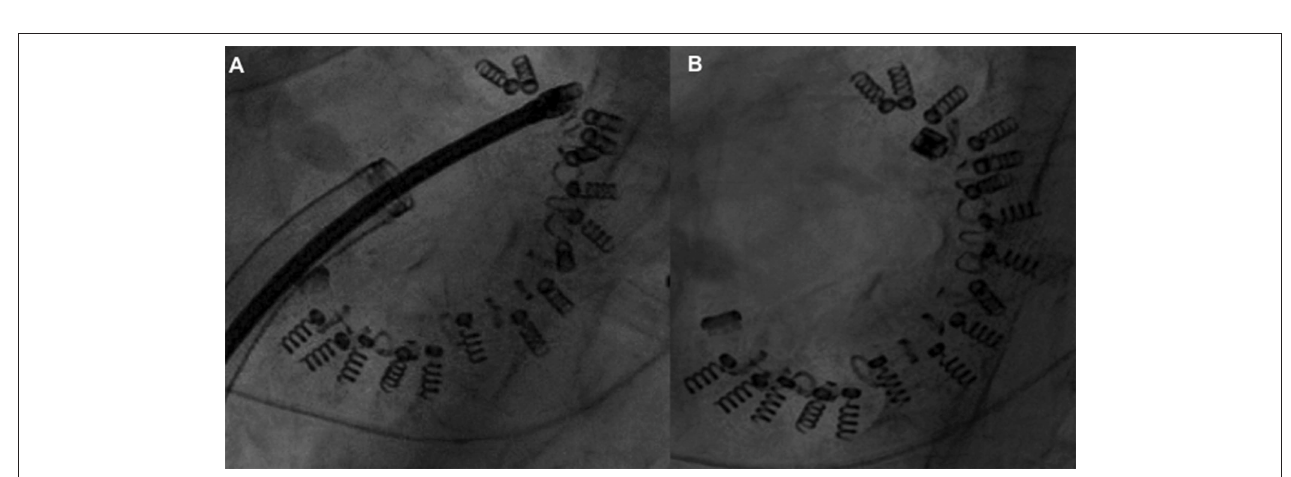
FIGURE 7 | (A,B) Guidewire rupture and implant contraction failure with loose of the cinching initially